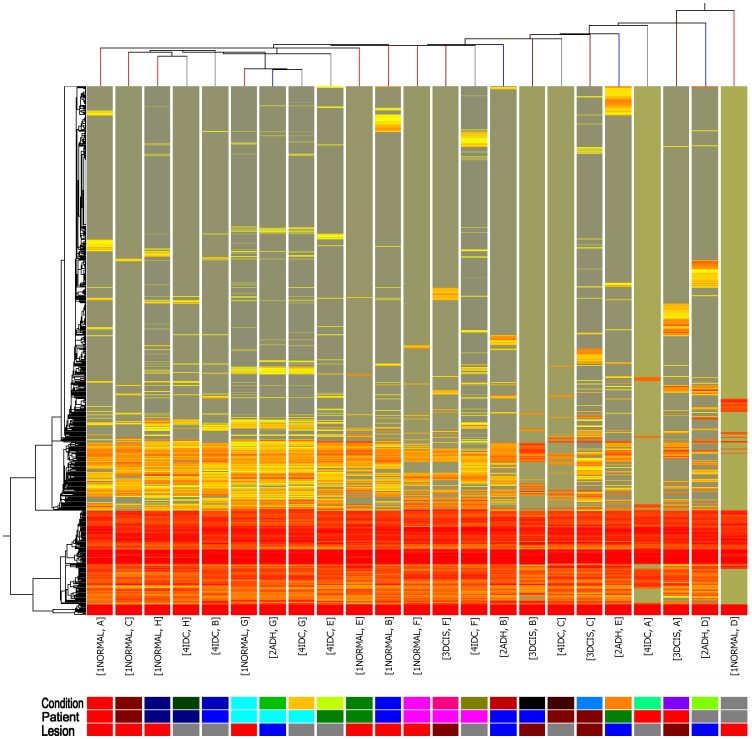
Unsupervised clustering results on both miRNAs and conditions of the 23 samples.One solid color box represents a certain condition. The clustering dendrogram indicates stages from the same patient were more closely clustered than those from the same stages.